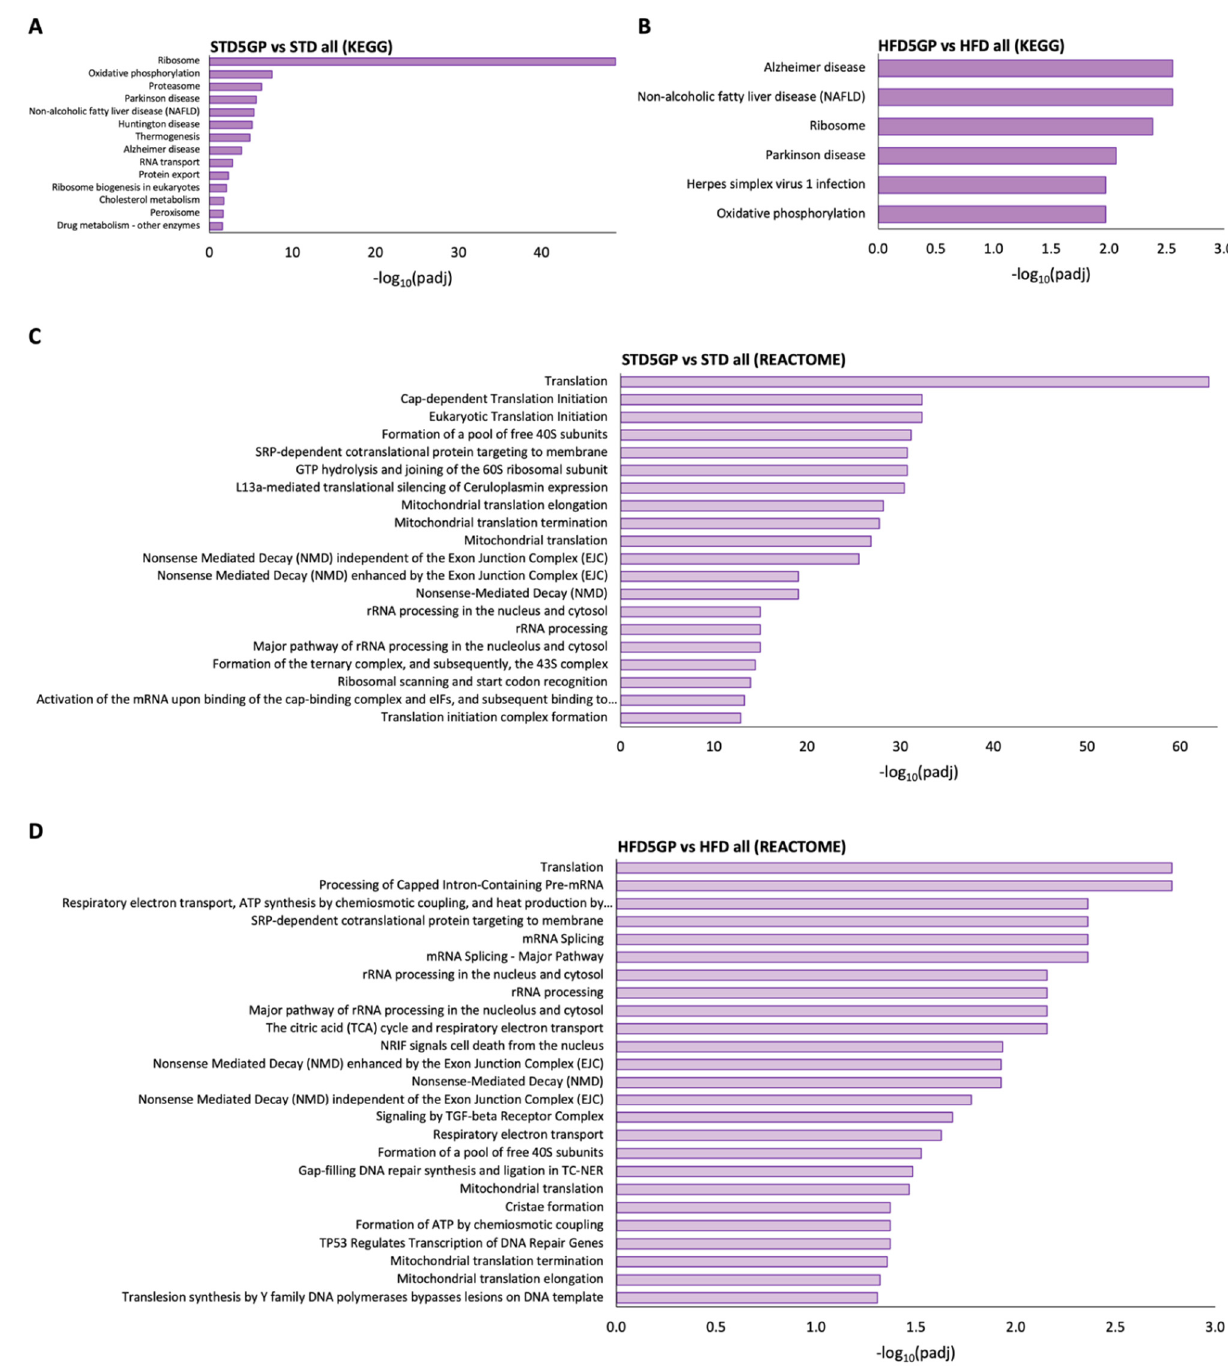
Figure 7. Dietary grape powder supplementation shows enrichment for terms/pathways associated with translation in mouse liver irrespective of fat content. ( A ) KEGG pathway analysis showing the top significantly enriched terms for the gene set differentially expressed in the liver of the STD5GP group compared with the STD group. ( B ) KEGG pathway analysis showing the top signif- icantly enriched terms for the gene set differentially expressed in the liver of the HFD5GP group compared with the HFD group. − log 10 (Padj) > 1.3 (Padj < 0.05) was considered as statistically signif- icant enrichment. ( C ) Reactome pathway analysis showing the top significantly enriched terms for the gene set differentially expressed in the liver of the STD5GP group compared with the STD group. ( D ) Reactome pathway analysis showing the top significantly enriched terms for the gene set dif- ferentially expressed in the liver of the HFD5GP group compared with the HFD group. − log 10 (Padj) > 1.3 (Padj < 0.05) was considered as statistically significant enrichment.